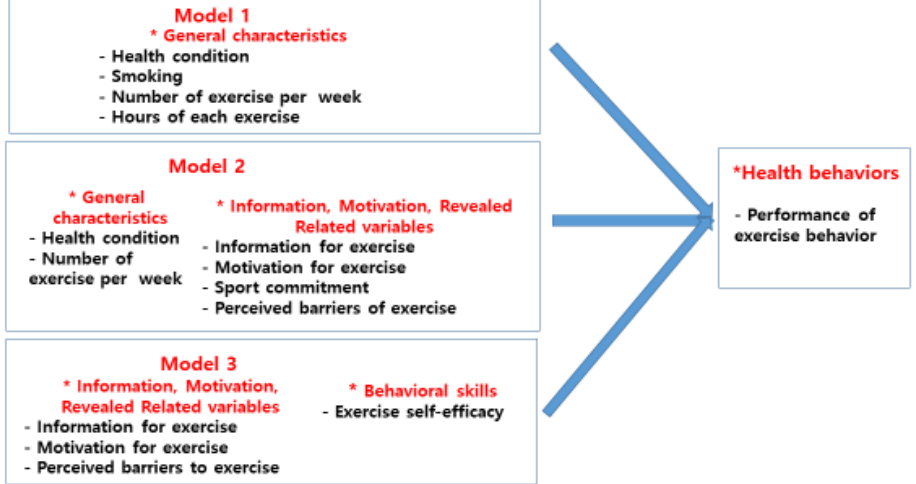
Figure 2. Information–Motivation–Behavioral skill-Revealed related variables (IMBR) Model. * equals spot. There’s no special meaning.